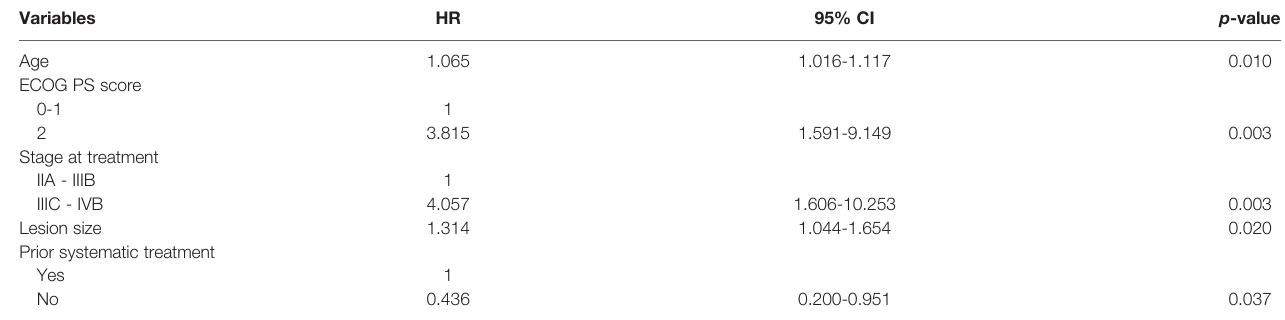
OS, overall survival; CI, con fi dence interval; ECOG PS, Eastern Cooperative Oncology Group performance